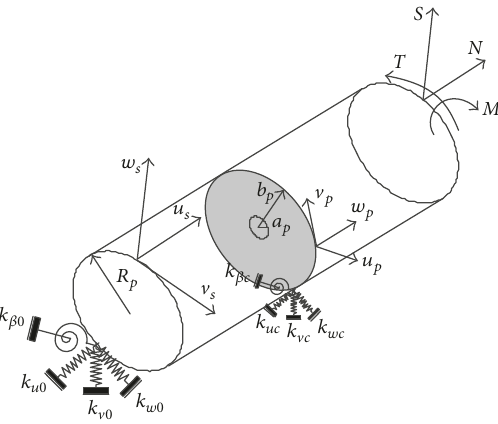
Figure 1: Coordinate system of the 𝑆 - 𝑃 coupled